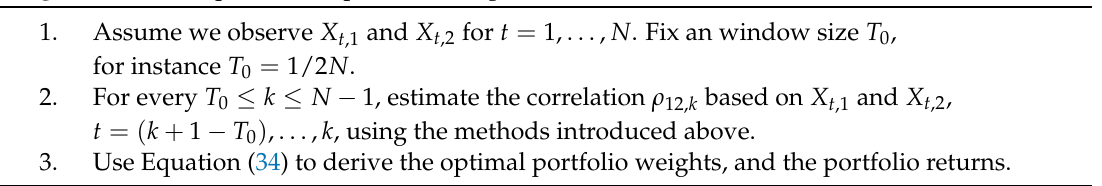
Algorithm 1: Computation of portfolio weights and associated returns.